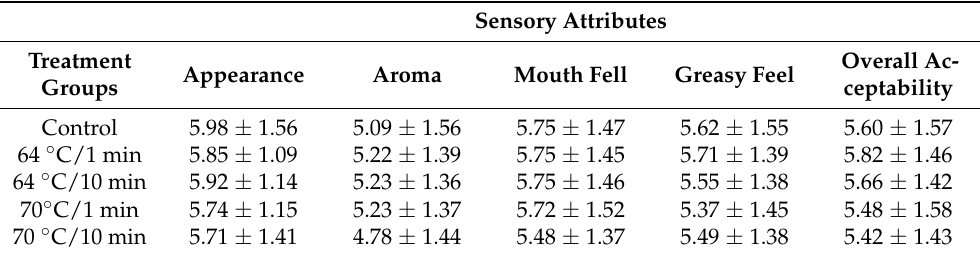
Table 4. Sensory attributes of mayonnaise prepared from thermally processed LEY. Sensory